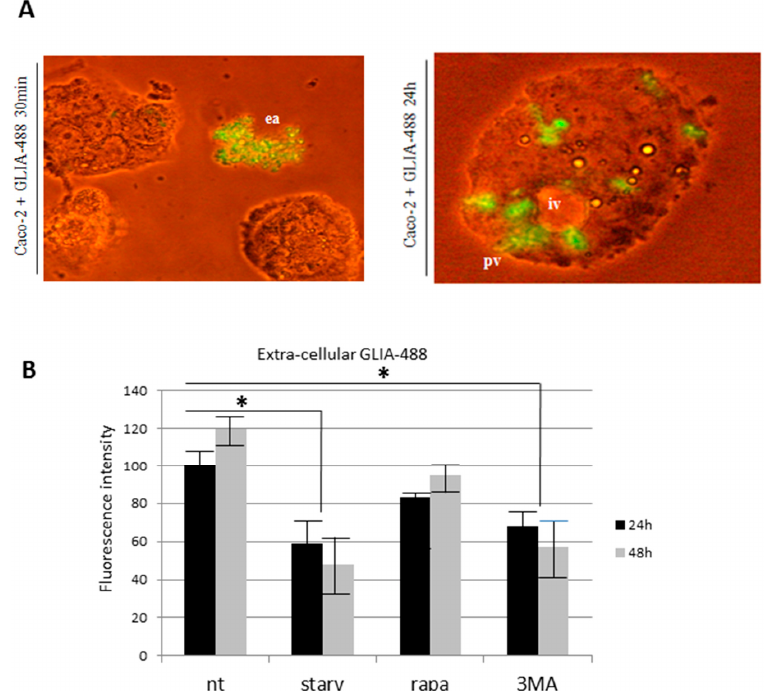
Figure 12. Extra- and intra-cellular evaluation of fluorescent PT-gliadin in Caco-2 cells. ( A ) Different time intervals of GLIA-488 administration (1 µ g/ µ L) were reported (left, 30 min. p.t.: right, 24 h p.t.). Note a large autophagosome-like vesicle in the right Panel storing large fluorescent aggregates (ea: extra-cellular aggregates; pv: perimembrane exocytic vesicles; iv: intra-cellular vesicles). Scale bars = 10 µ m; ( B ) GLIA-488 fluorescent labelled digested gliadin (1 µ g/ µ L) was administered to growing Caco-2 cells in presence of starvation conditions, rapamycyn (5 µ M) and 3-MA (5 mM) treatments. Media were collected and analysed by fluorimeter (ext. 492 nm–emis. 517 nm). Asterisks indicates statistical significance p < 0.05, Anova One-way, compared to untreated sample (nt). Fluorescence was reported as arbitrary units. SD bars ( n = 3) are